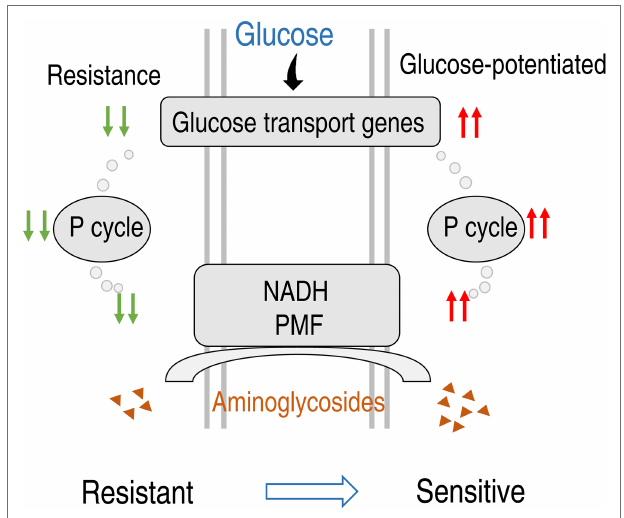
FIGURE 8 | Diagram for glucose-mediated SCF-resistant mechanism and reverting by exogenous